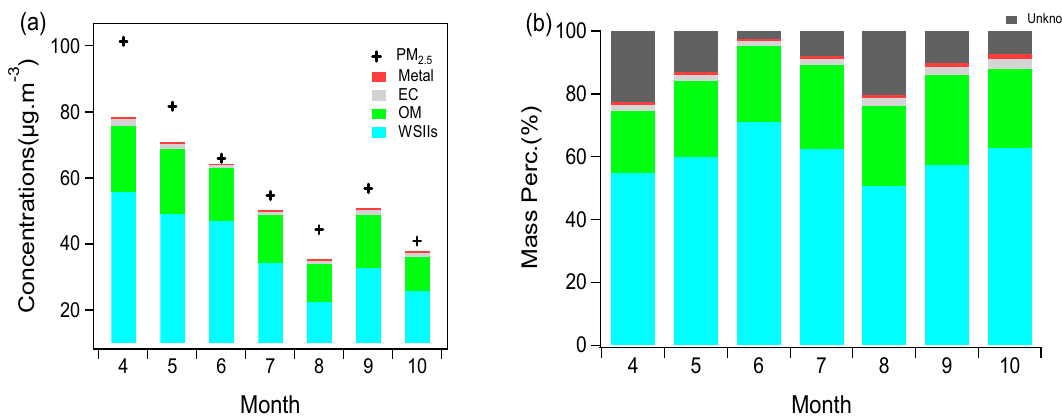
Figure 4. Monthly averaged chemical compositions and mass concentrations of PM 2.5 ( a ), and mass contributions of different components to PM 2.5 ( b ).